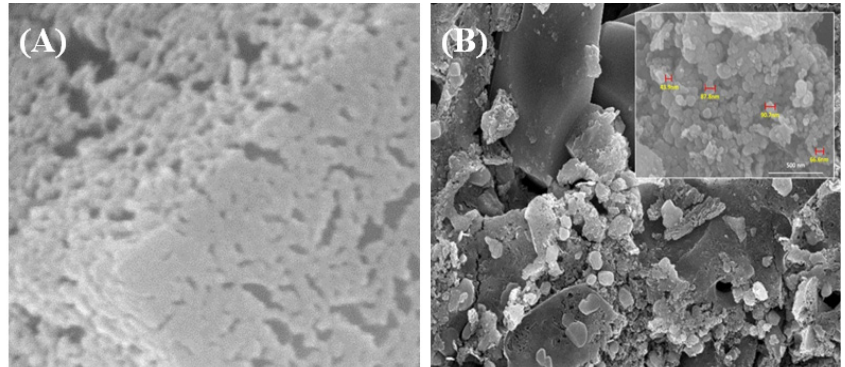
Fig.3. (A) Before treatment, (B) After treatment